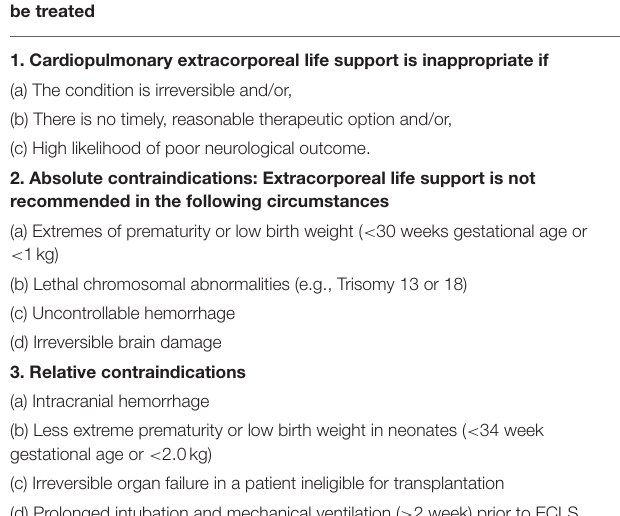
TABLE 5 | Contraindications to cardiac ECMO according to the ELSO guidelines (33). Use of ECLS is not recommended under certain circumstances, particularly if there is strong evidence for lack of capacity to recover or